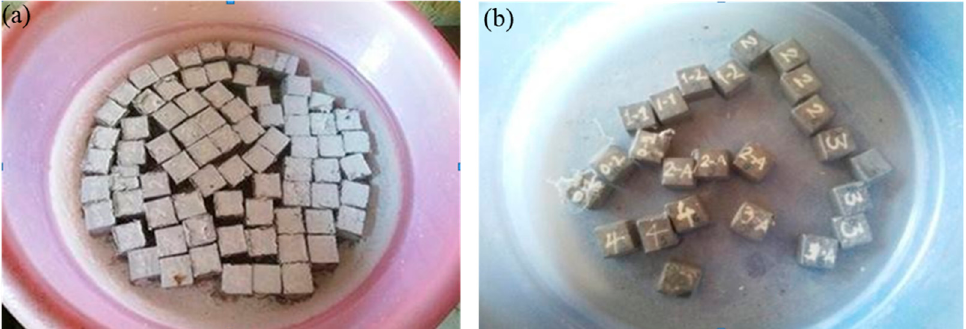
Figure 1. Cement paste specimens of the chloride and sulfate ion permeability tests: ( a ) specimens soaked in 10% MgSO 4 solution and ( b ) specimens soaked in seawater.